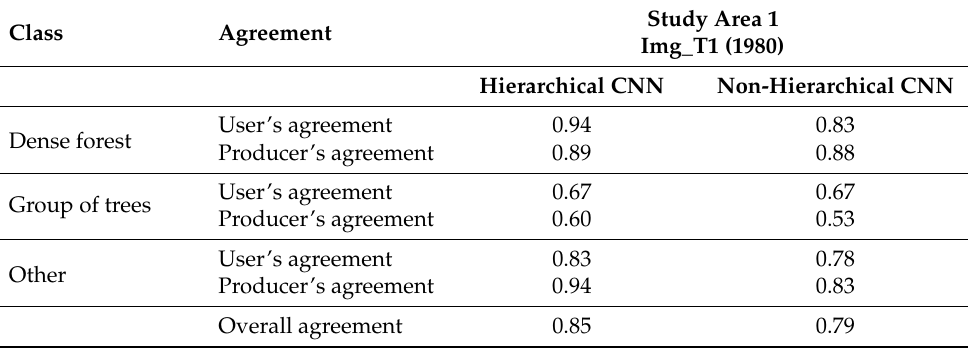
Table 3. Overall user’s and producer’s agreement between classifications either with or without hierarchy and visual image interpretation for the three classes “dense forest”, “group of trees”, and “other”. Note that in study area 1 image patches from 2009 were used as training data and were therefore excluded from the agreement analysis.